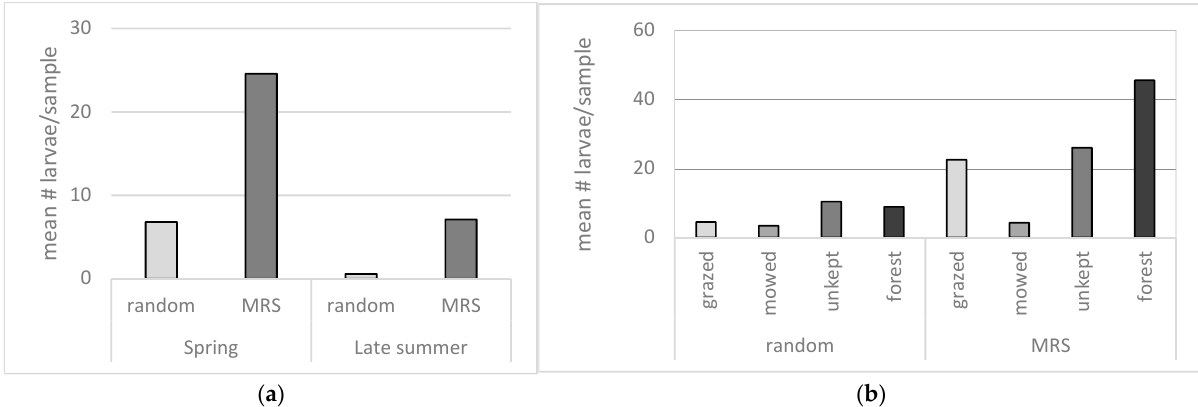
Figure 2. ( a ) Mean number of mosquito larvae hatched per sample in random and moisture retaining structures (MRS) samples, sampled during spring and late summer. ( b ) Mean number of mosquito larvae per sample in the four environmental categories, random, and MRS samples.